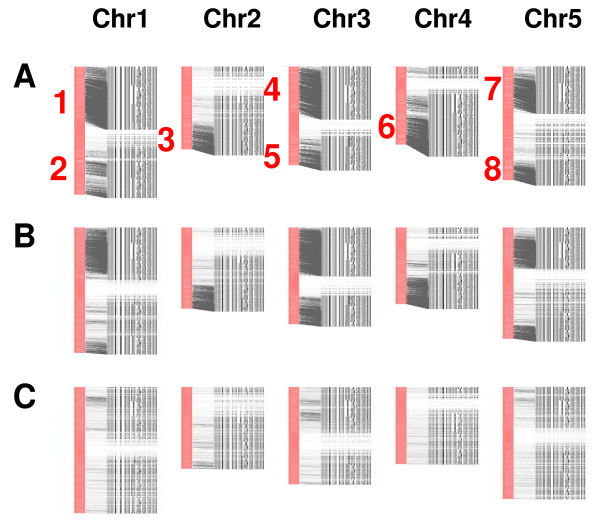
Hot spots of putative xylem orthologs on the chromosomes of Arabidopsis. The 1,003 loblolly pine xylem unigenes highly conserved in other vascular plants (xylem orthologs) have strong homology (1e-50) with 3,115 loci and moderate homology (1e-5) with 6,563 loci in the Arabidopsis genome. Positioning of these homologs on the five chromosomes of Arabidopsis revealed eight hot spots of putative Arabidopsis xylem orthologs. A: 3,115 highly homologous loci; B: 6,563 moderately homologous loci; C: 6,000 randomly selected loci.